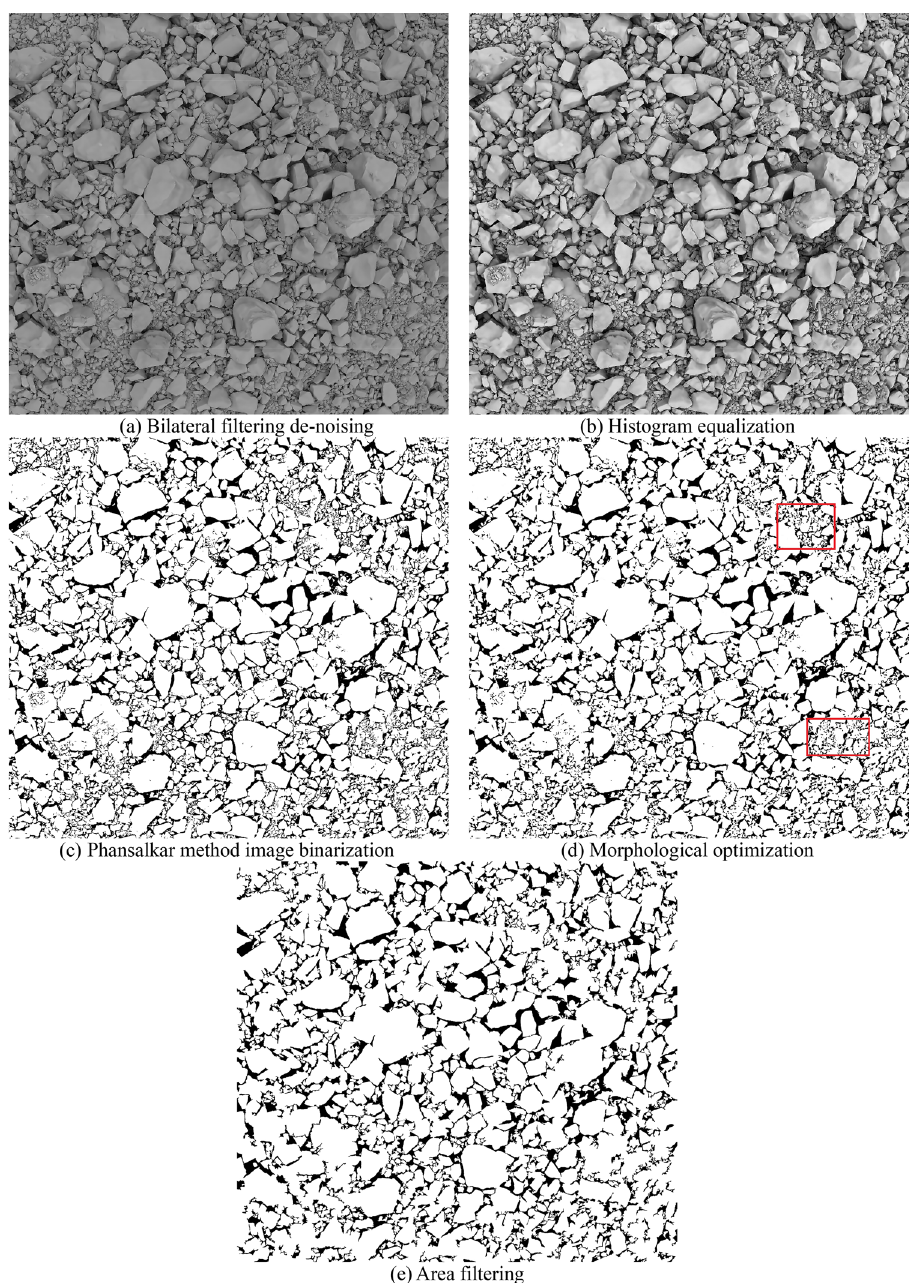
Figure 5. Image pre-processing effect of limestone blasting